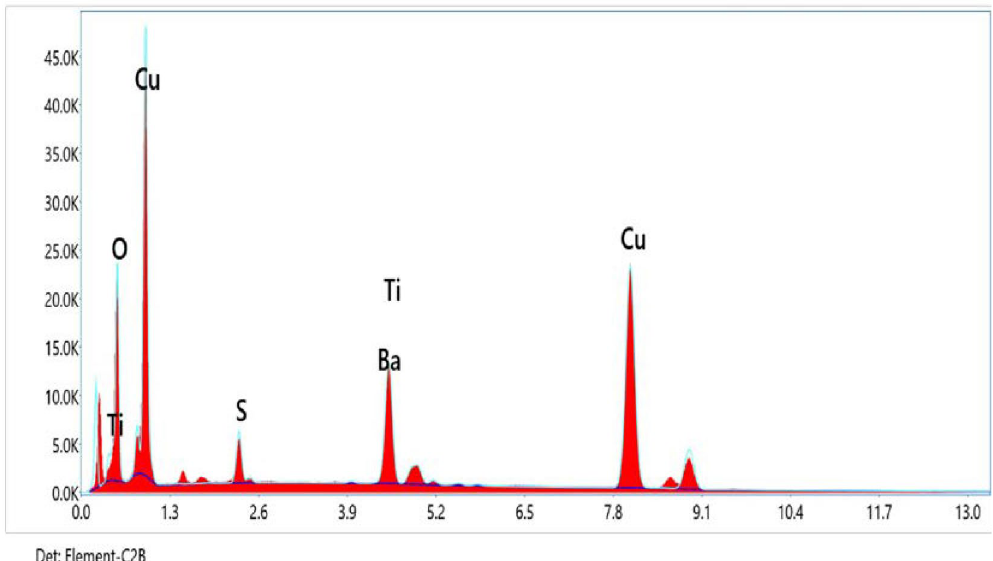
Figure 5. Representative the EDX image of Cu–TiO 2 nanoparticles and you can see the existence of Cu and Ti with a higher ratio. The blue color represents the Cu without TiO 2 , and the red color represents the Cu with 40 wt.% of TiO 2 . It is noticed that the composite powders contain peaks for Cu, Ti, and O atoms.